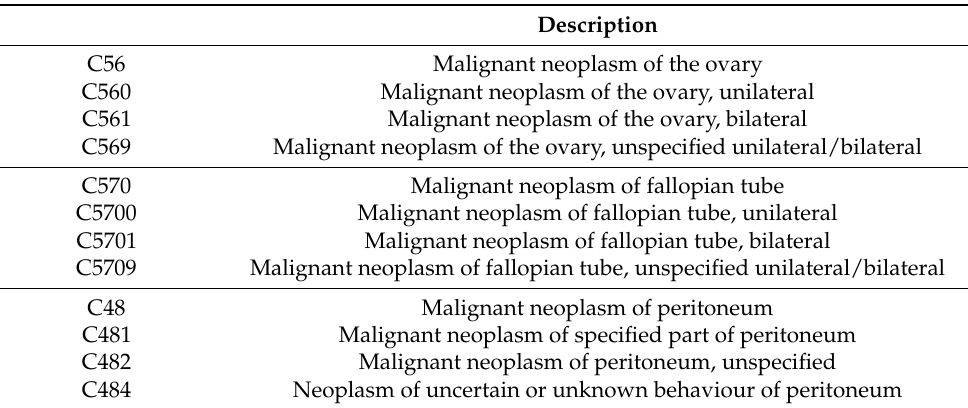
Table A2. ICD-10 codes included for ovarian cancer diagnoses.